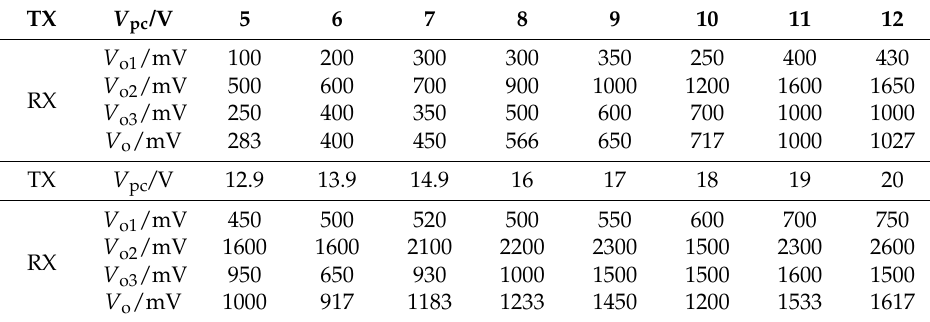
Table 1. The output testing of pulse